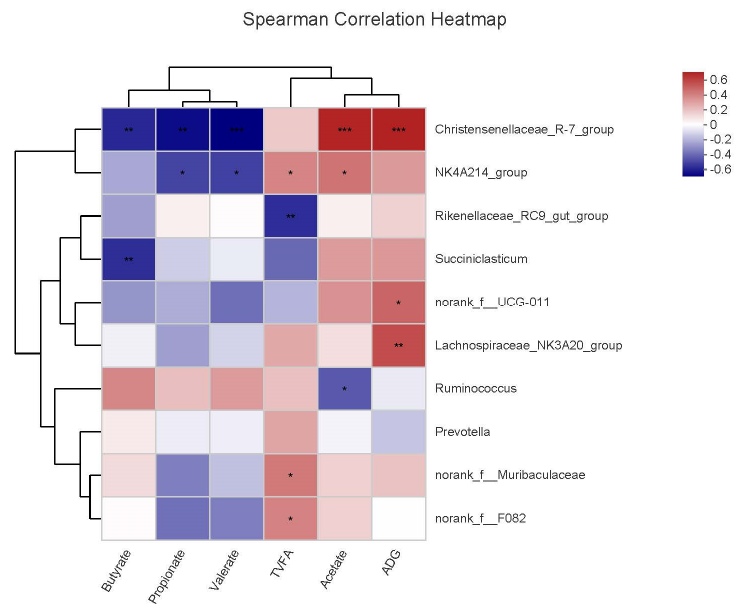
Figure 7. Heat map of the correlation among the relative abundance of microorganisms, VFAs, and ADG. * p < 0.05, ** p < 0.01, *** p < 0.001.